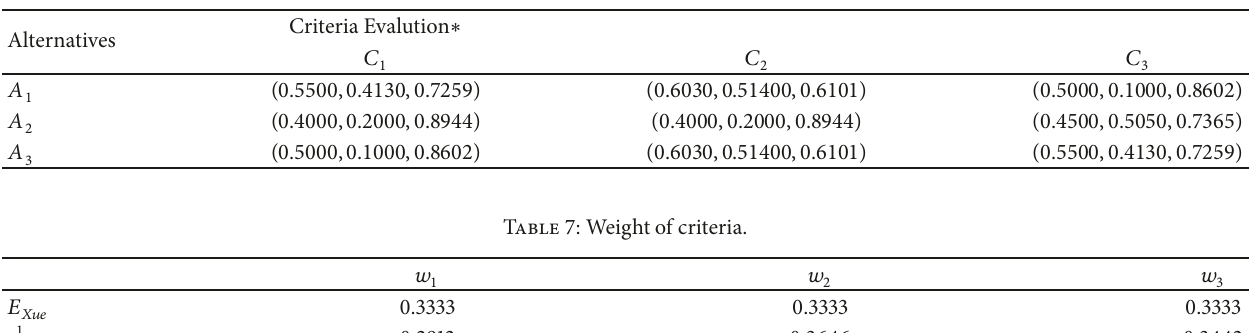
Table 6: Pythagorean fuzzy decision matrices.